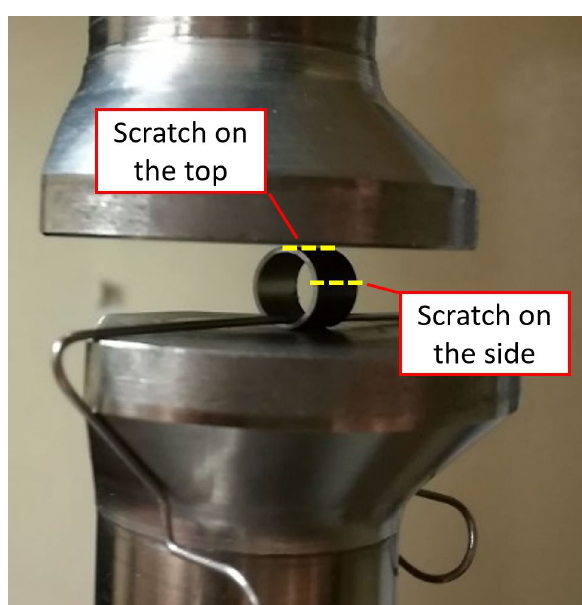
Figure 11. Ring Compression Test with the position of the scratch.